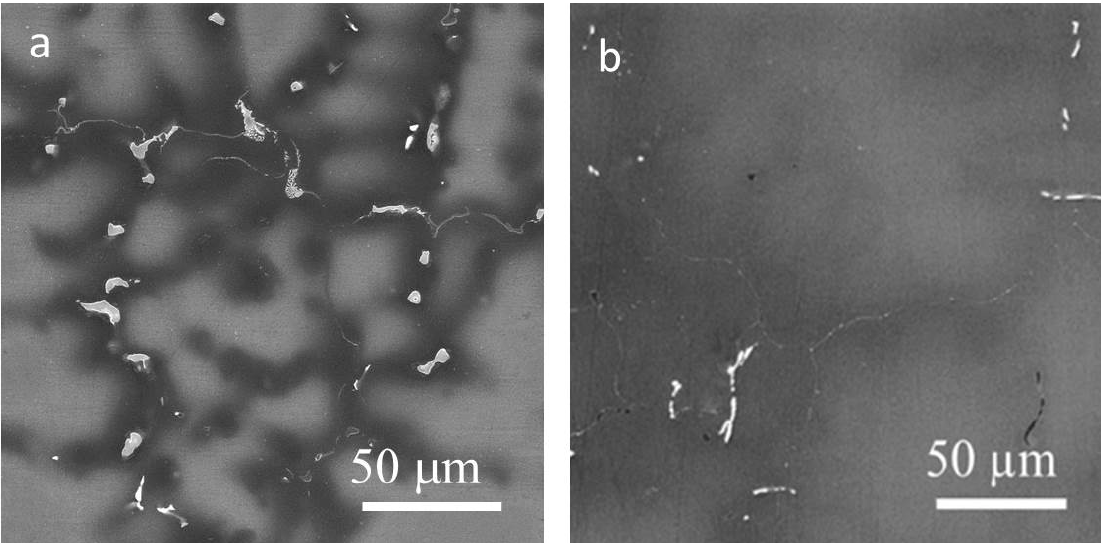
Figure 1. SEM micrographs of the cast alloy before annealing ( a ) and after annealing ( b